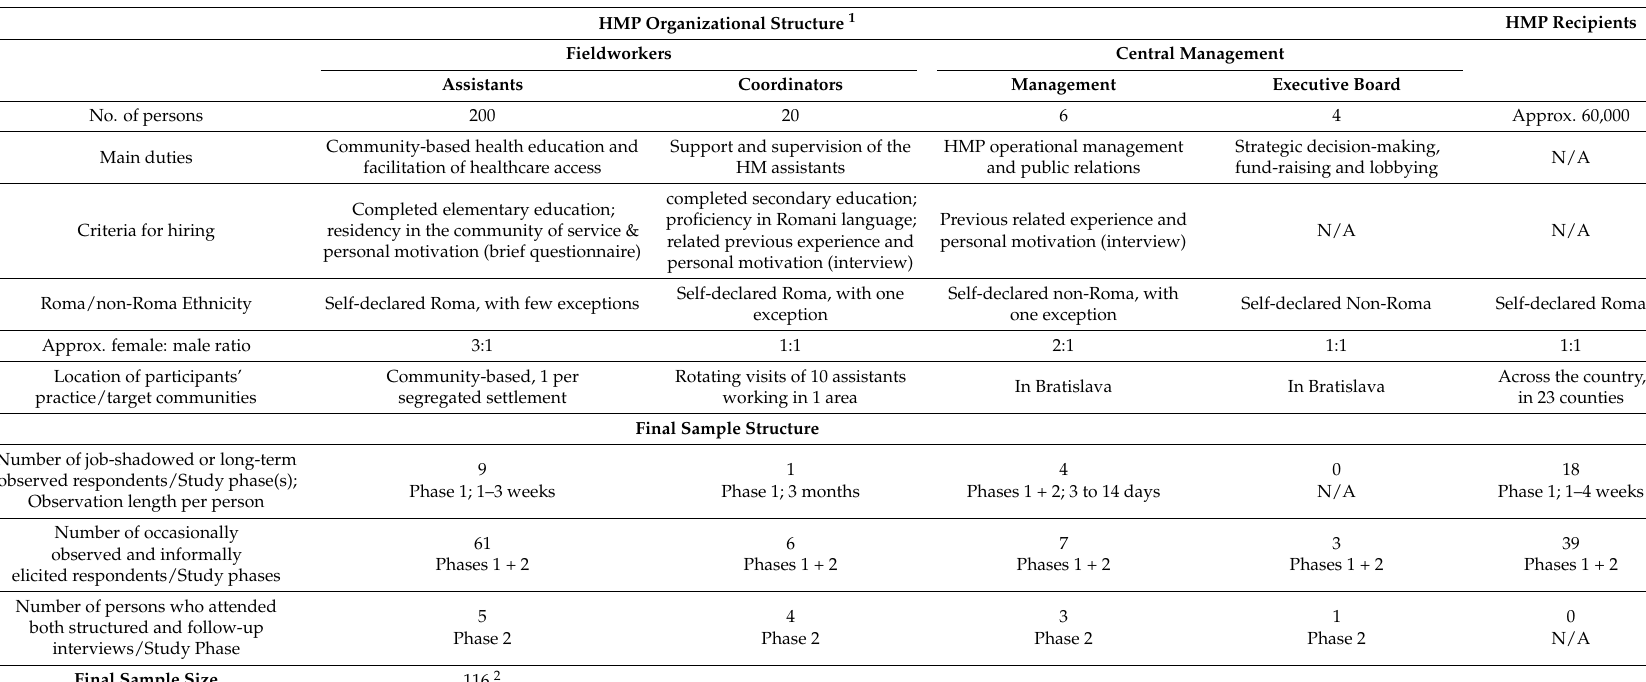
Table 1. The organizational structure of the evaluated health-mediation program (HMP) and the structure of the final